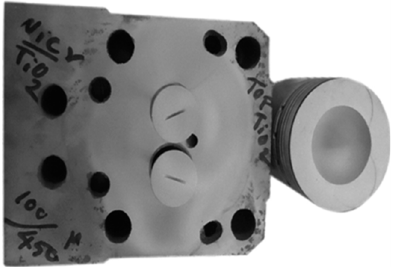
Figure 20. Photographic view of 450 lm TiO 2 coated piston, valves, and cylinder head (Reproduced from [59], with the permission of AIP Publishing).